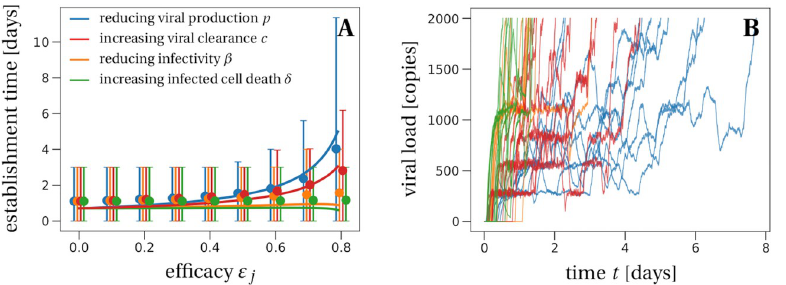
Fig 4. The mean time to reach a detectable viral load at the infection site. Panel A: Solid lines represent the theoretical prediction of the average time for the viral infection to reach 2, 000 virions (see Section F in S1 Text for details). We used the LowN parameter set to simulate 10, 000 stochastic simulations that reached a viral load of 2, 000 total virus particles when starting with an inoculum of V (0) = 1. Dots are the average times calculated from these I simulations, bars represent 90% of the simulated establishment times. We only consider efficacies below the critical efficacy ( ε j < 0.87, cf. Fig 2A) because above the critical efficacy infection is never established. Panel B: We plot 10 = 0.75). example trajectories that reach the detectable viral load for each of the four types of treatment (efficacy ε j Under treatment that increases the infected cell death δ or reduces infectivity β , establishing trajectories reach the detectable viral load almost immediately. In contrast, drugs that directly affect the number of virus particles, i.e. clearance c or production p , allow for trajectories that fluctuate much more, explaining the larger average detection times and the larger variation of detection times for these scenarios.